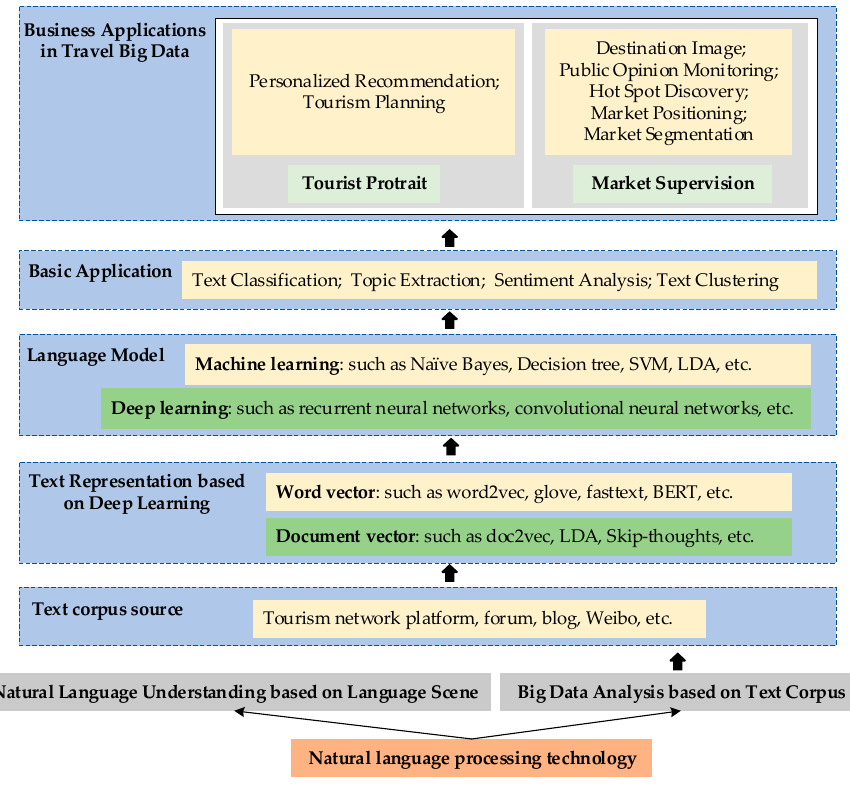
Figure 1. Text corpus-based tourism big data mining.